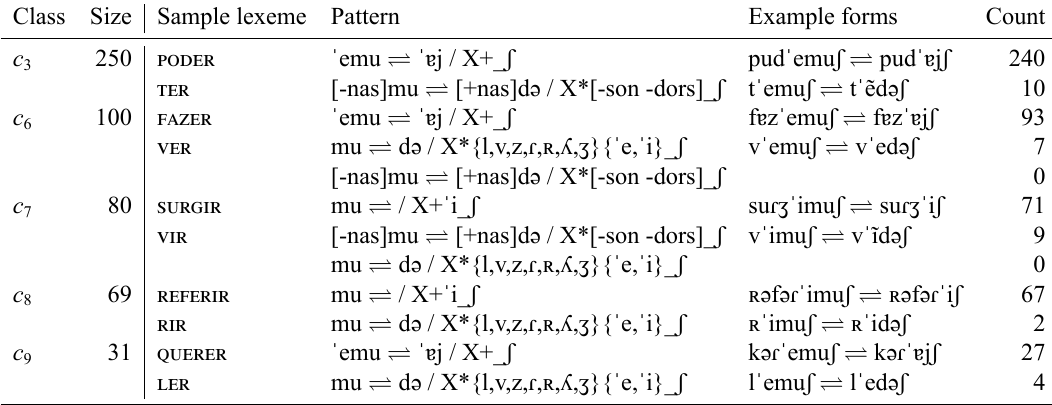
Table 24: Classes of PRS.IND.1PL relevant for the prediction of PRS.IND.2PL in which verbs can belong to either of two